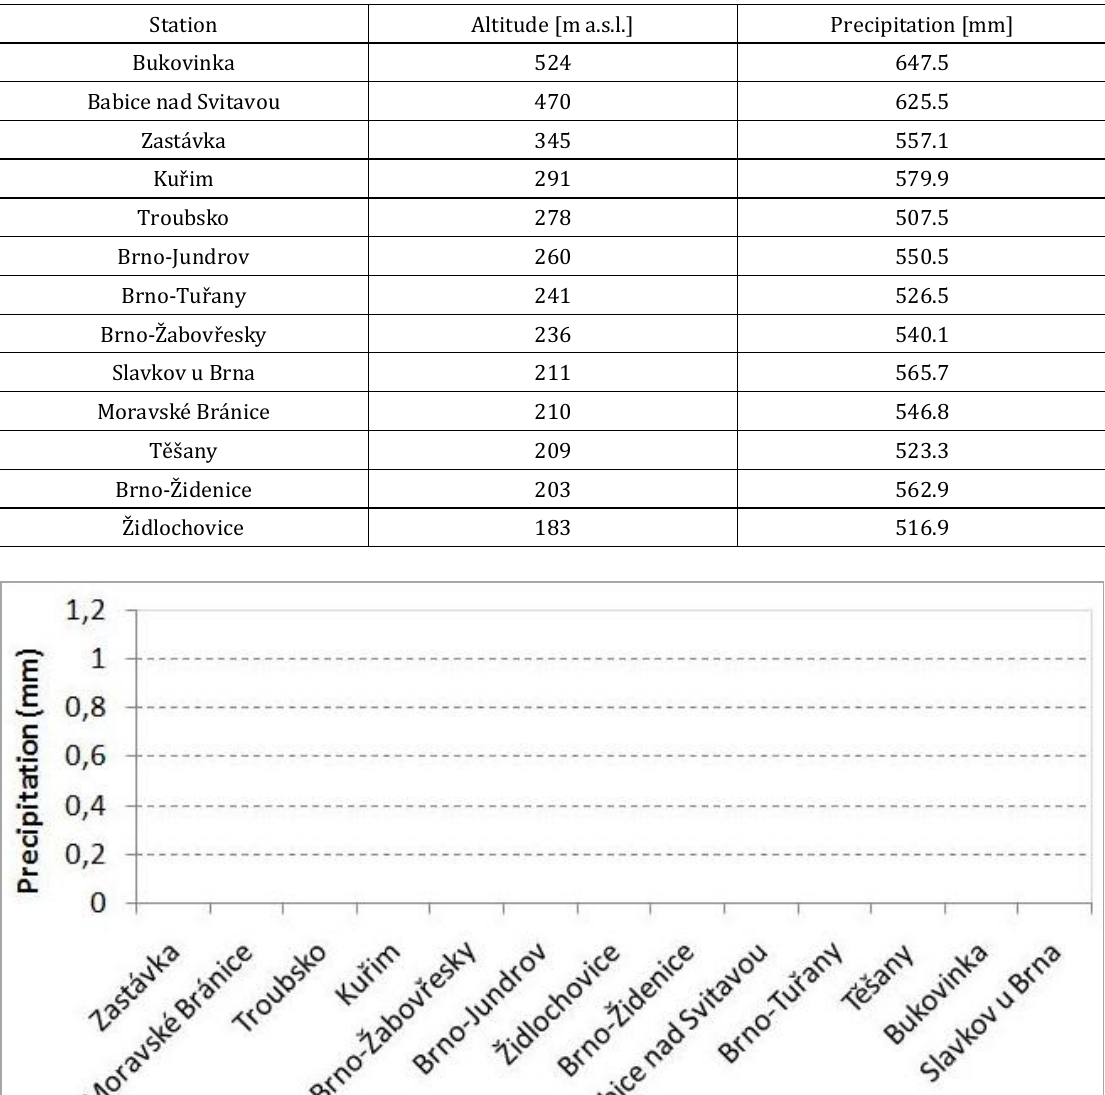
Table 4. Annual rainfall totals average in Brno (2010-2014)